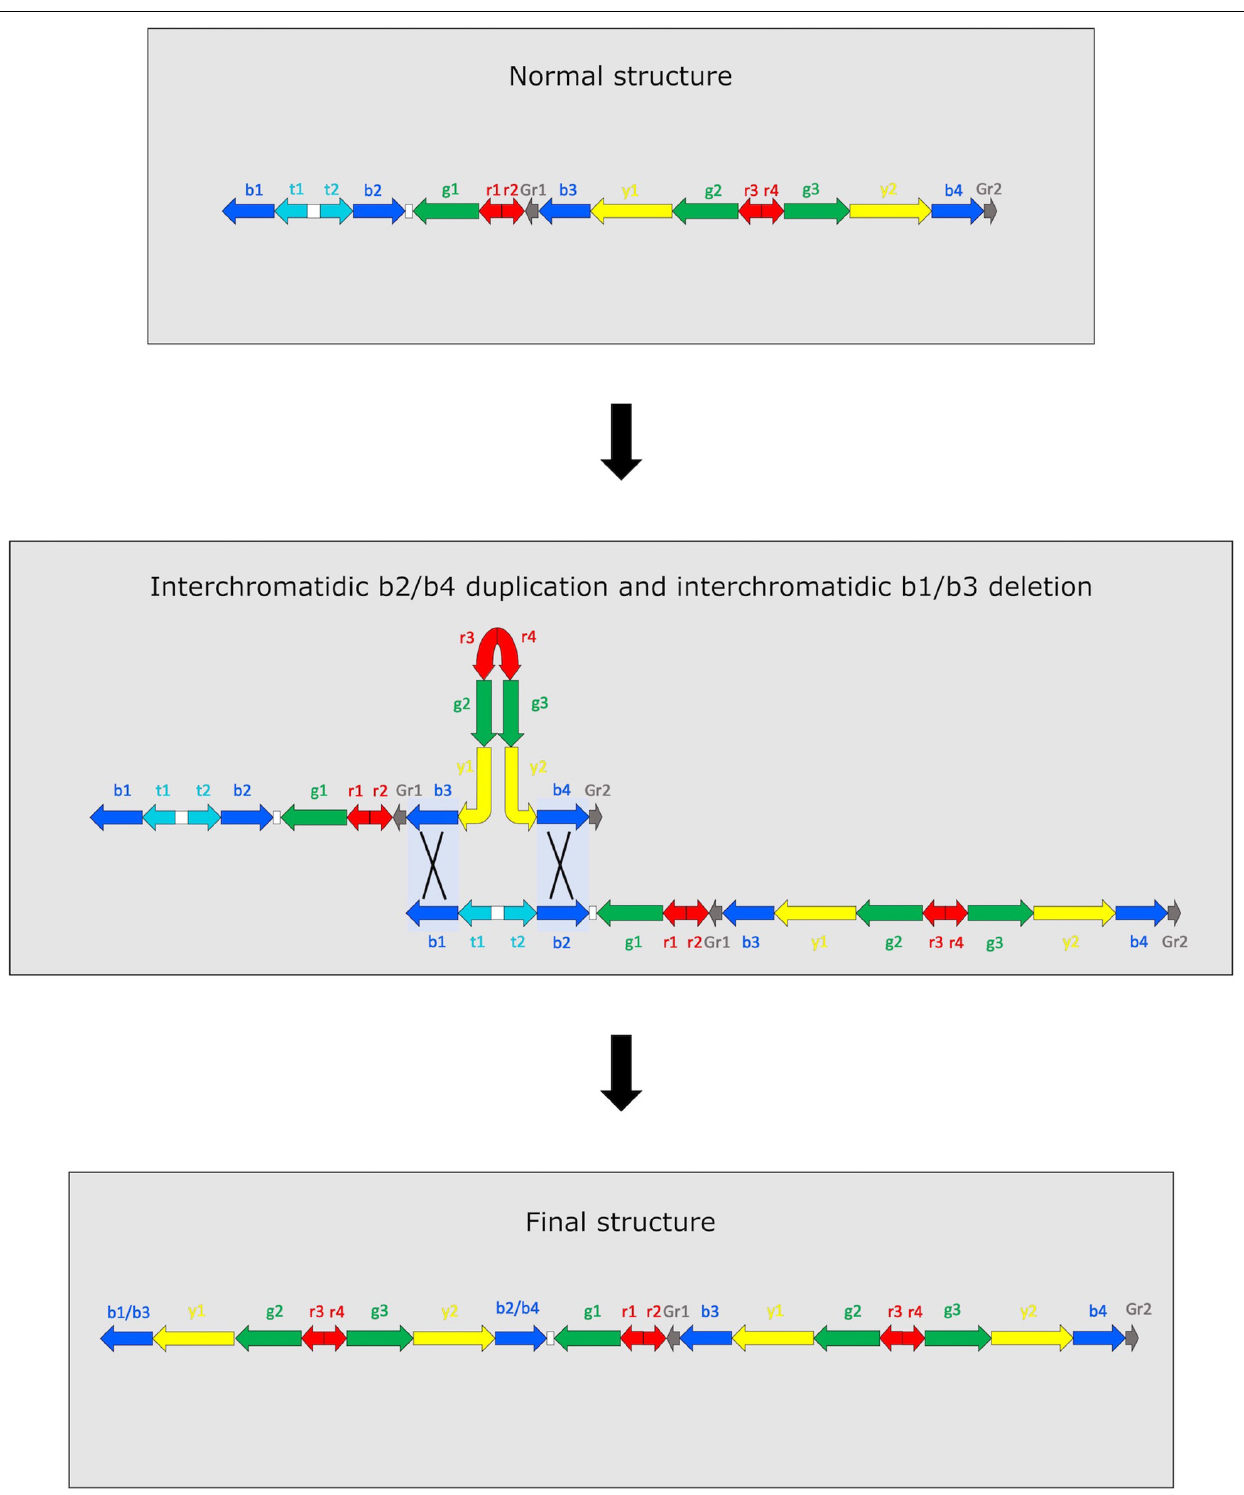
FIGURE 2 | Representation of the two simultaneous NAHR events that may have led to DYS448 deletion and DYF387S1 duplication. Since it is not possible to determine which part of the amplicon copy remains after the recombinational events, they are indicated as hybrid copies (b2/b4 and b1/b3). The not observed recombinant chromatid is not